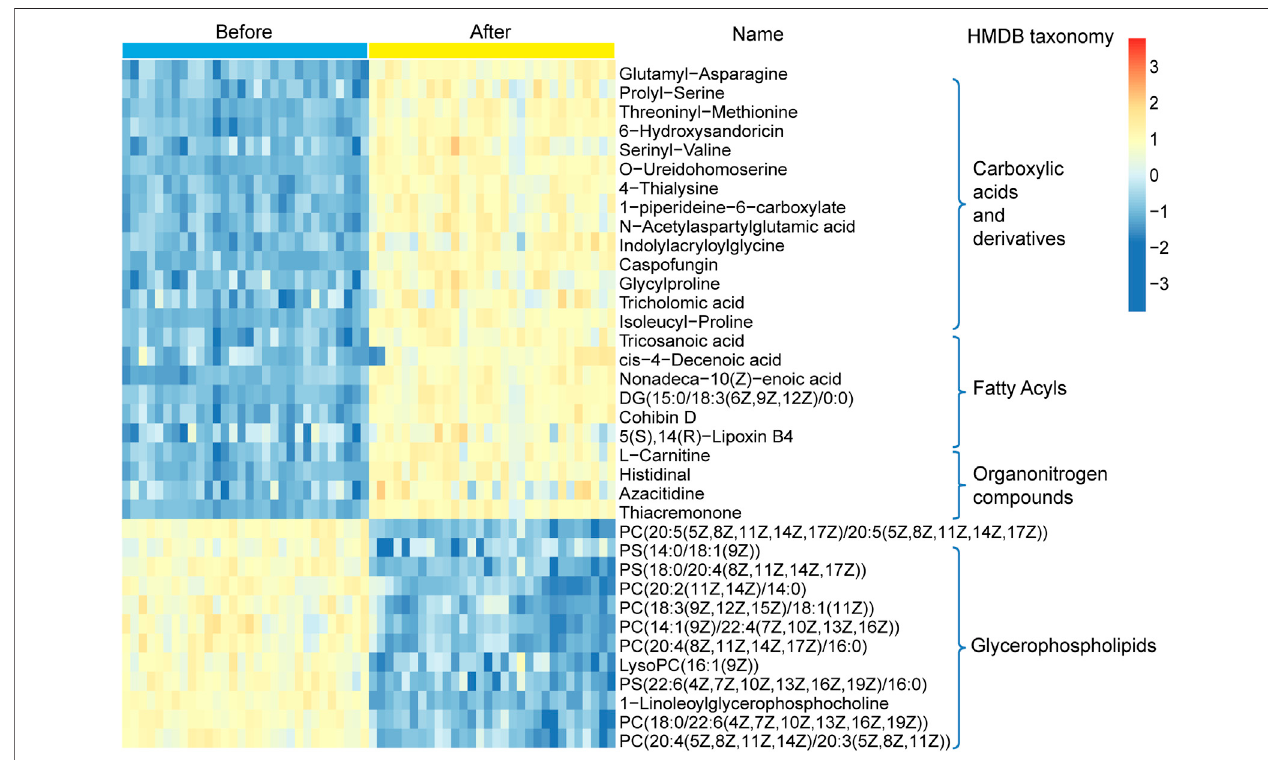
FIGURE 5 | Hierarchical clustering analysis for the circulating metabolites in the before- and after-administration groups based on their z-normalized abundance. The name and HMDB taxonomy clusters of the metabolites were listed.